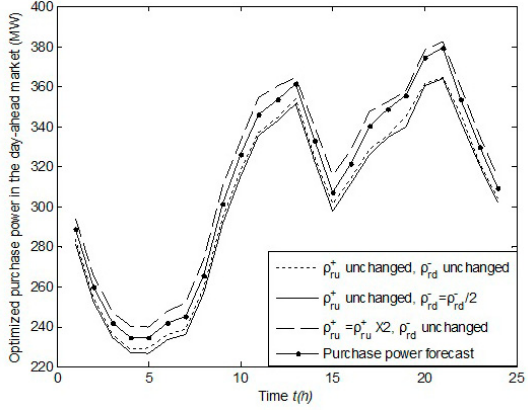
Figure 9. Impact of real-time prices on P o r ( t ) in the day-ahead market.